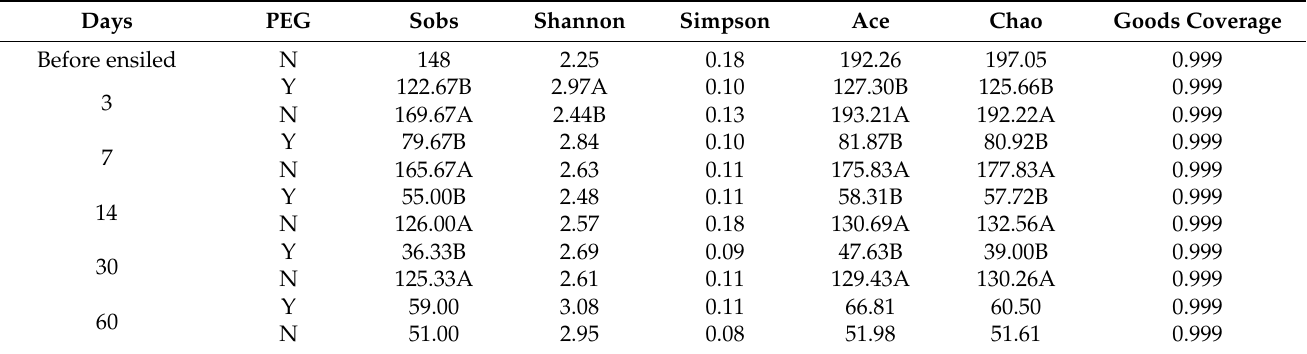
Table 4. Alpha diversity of fungi community of sainfoin ensiled with or without the addition of PEG.